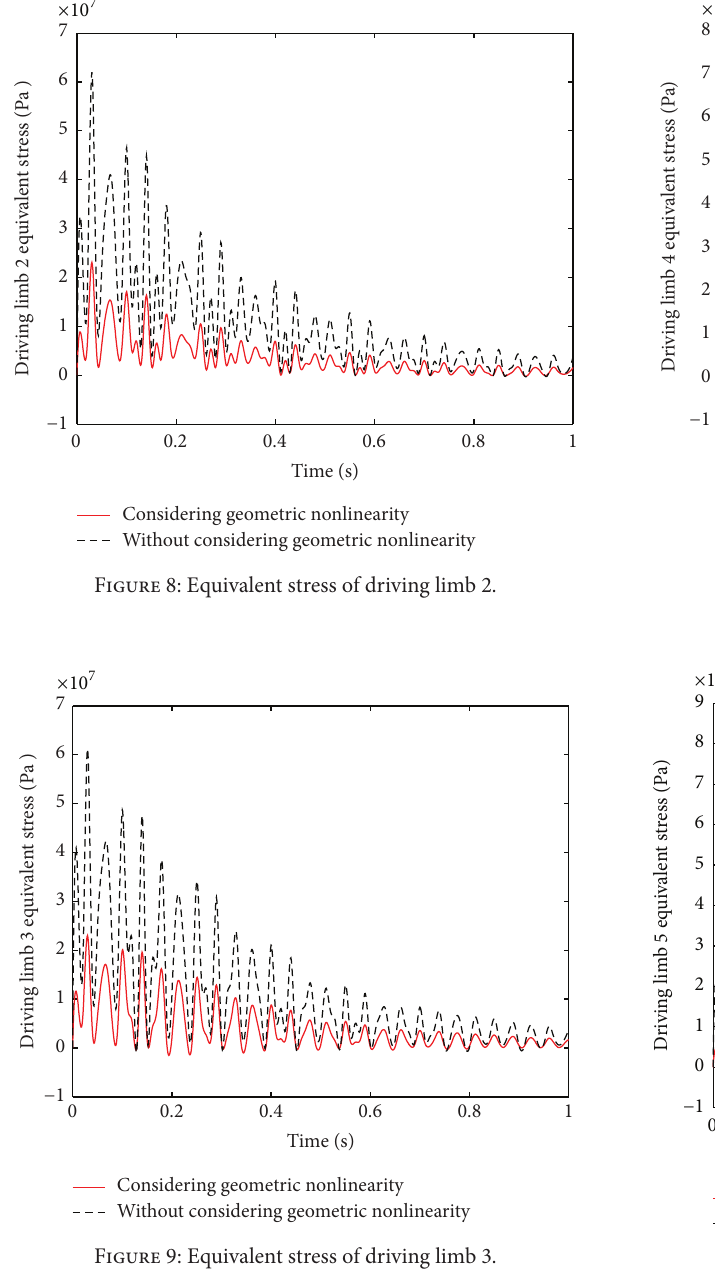
Figure 11: Equivalent stress of driving limb